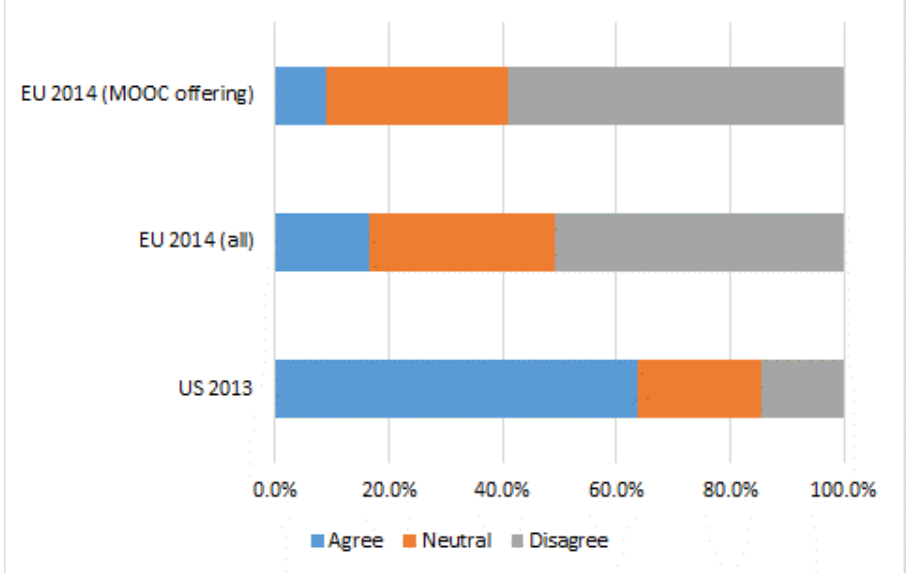
While in the U.S. survey, the opinions are mostly neutral or disagree, in the EU version a large majority of the respondents agree that “MOOCs are important to learn about online